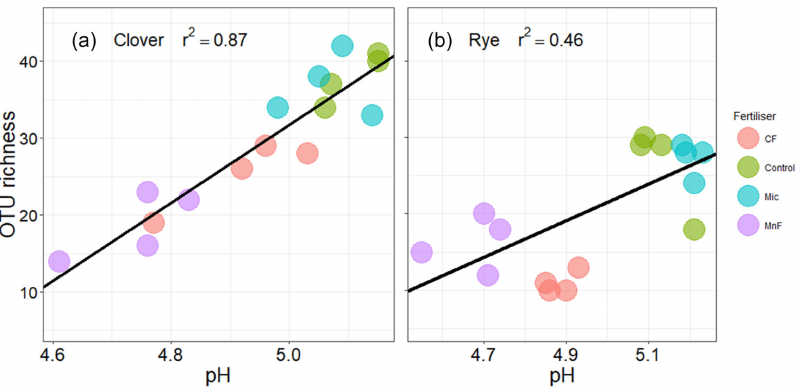
Figure 7. Mycorrhizal community (at 97% similarity OTU level) richness compared with soil pH for soil amended with a chemical fertilizer (CF), a rock mineral fertilizer (MnF), a microbial inoculant (Mic) and untreated soil (control) for ( a ) subterranean clover and ( b ) annual ryegrass at 10 weeks.